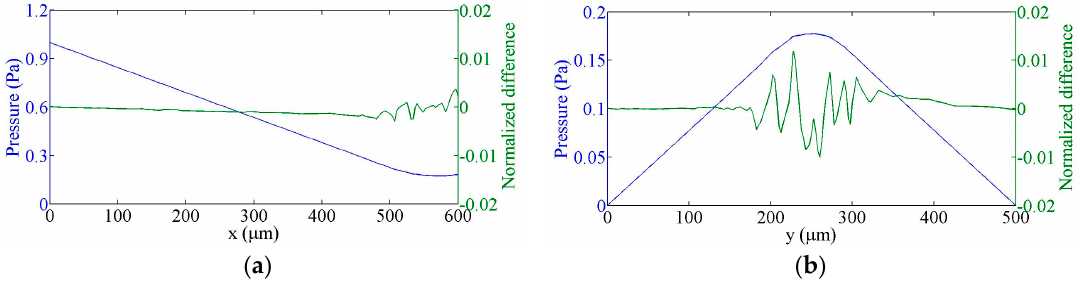
Figure 7. Q3D calculated pressure values and their normalized differences from COMSOL calculations, ( a ) along the centre of the input channel, ( b ) along the centre of the output channels.